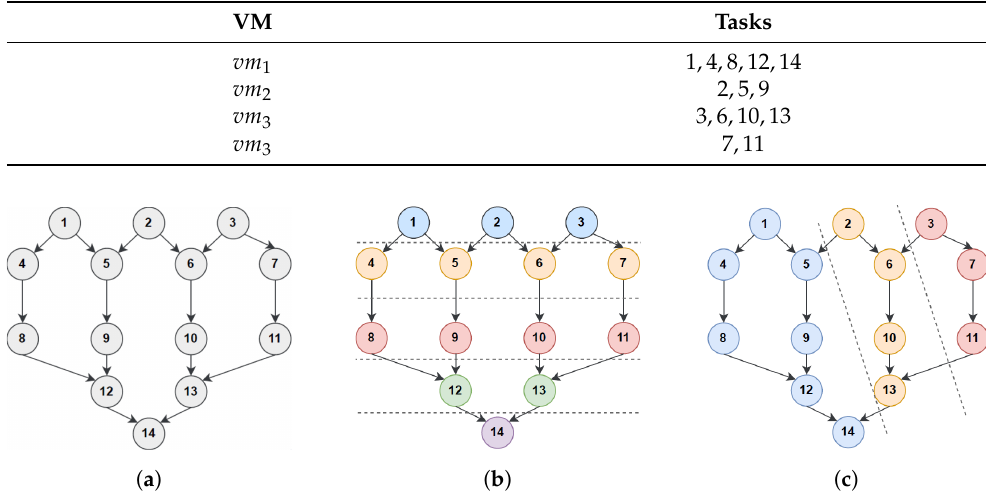
Table 1. Tasks assignment.